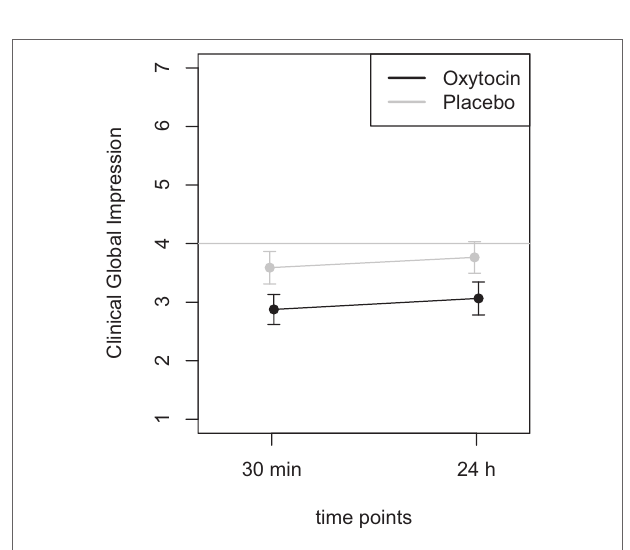
FigUre 4 | Average scores of the Clinical Global Impression scale (1–7). A rating of 4 on this scale indicates “no change.” Smaller numbers indicate an improvement of clinical symptoms (1 = “very much better,” 2 = “much better,” 3 = “minimally better”).